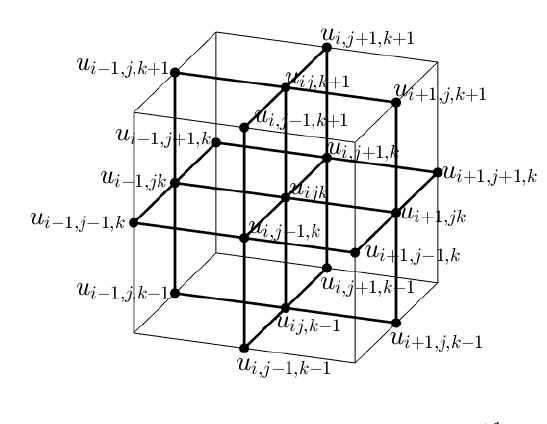
Figure 4. The 19-point discrete stencil for u n + 1